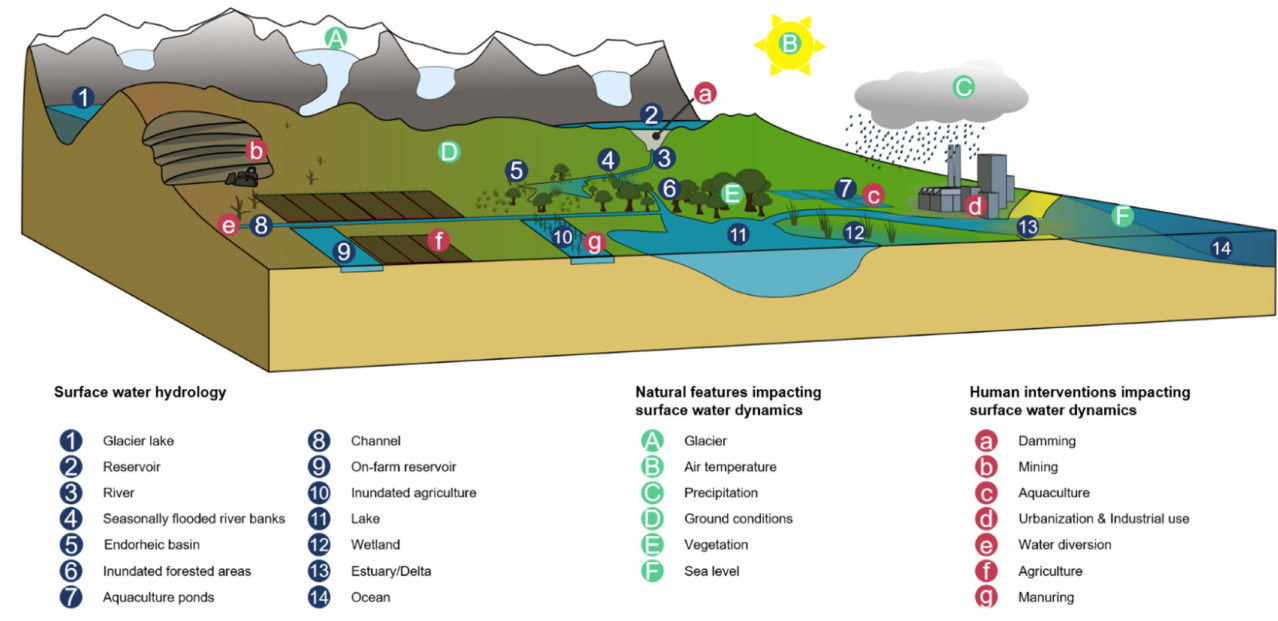
Figure 1. Model overview of surface water hydrology including natural and anthropological influ- ences that affect surface water